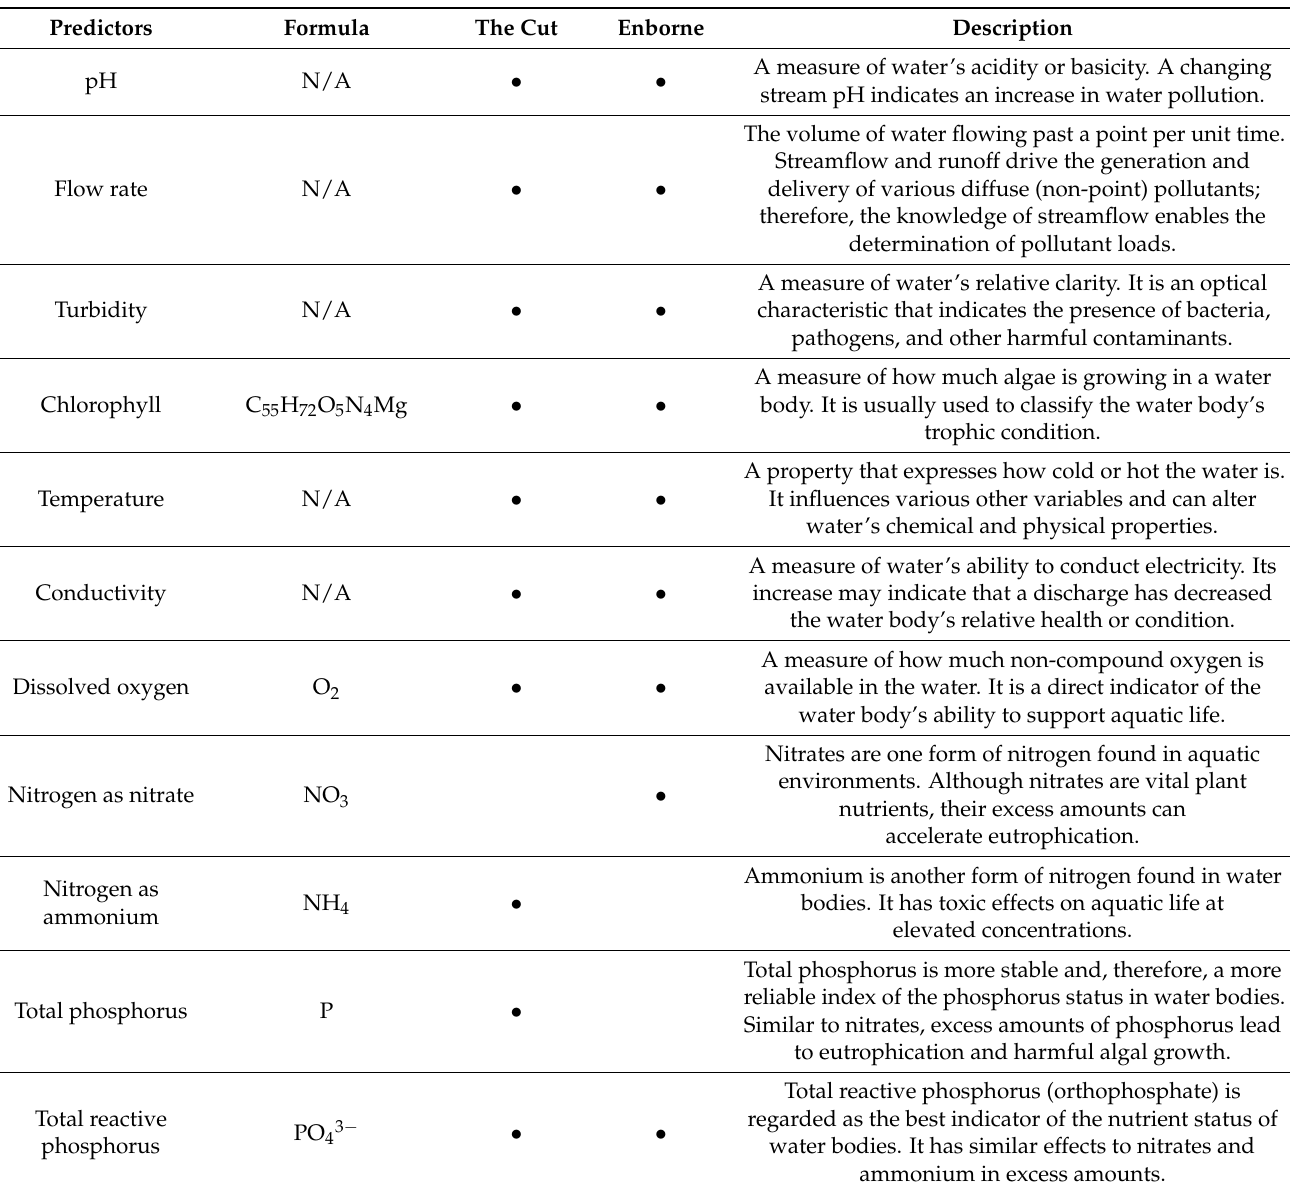
Table 1. Datasets used for virtual sensor development: parameters measured in each catchment, their chemical formulas, and descriptions where N/A denotes the absence of standard formulas and • indicates the catchment where the variable was